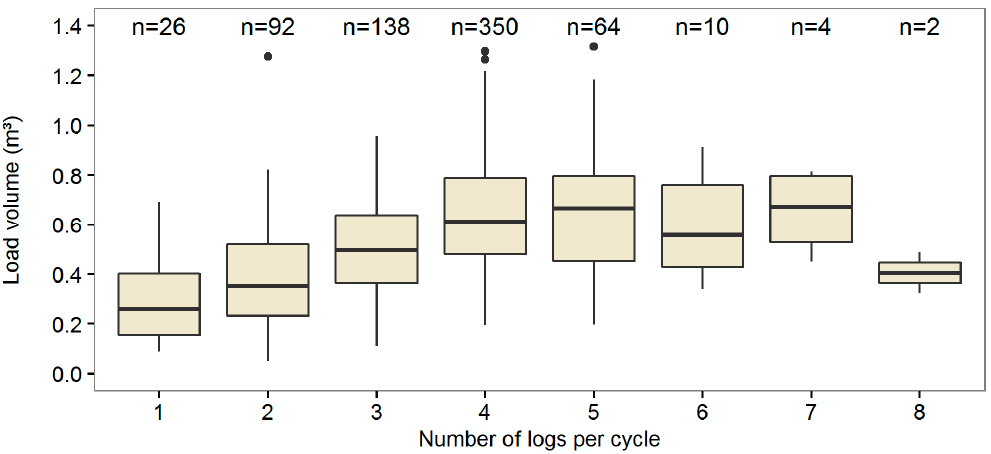
Figure 9. Cycle output expressed as load volume in m 3 ( y -axis) in relation to number of logs per cycle ( x -axis) and their associated frequency ( n ), indicating piece size based on detailed field recordings (campaigns A to D). A box contains 50% of all observations and is bordered by the upper and lower quartile. The crossline within the box indicates the median. Whiskers cover the 1.5 interquartile range and dots represent outliers.